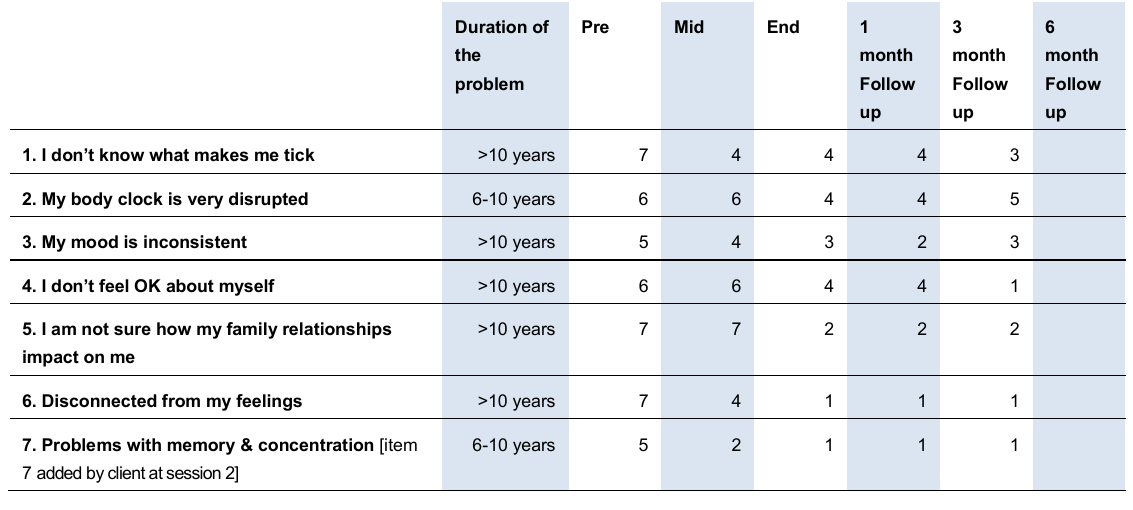
Table 5: PQ Ratings and Duration